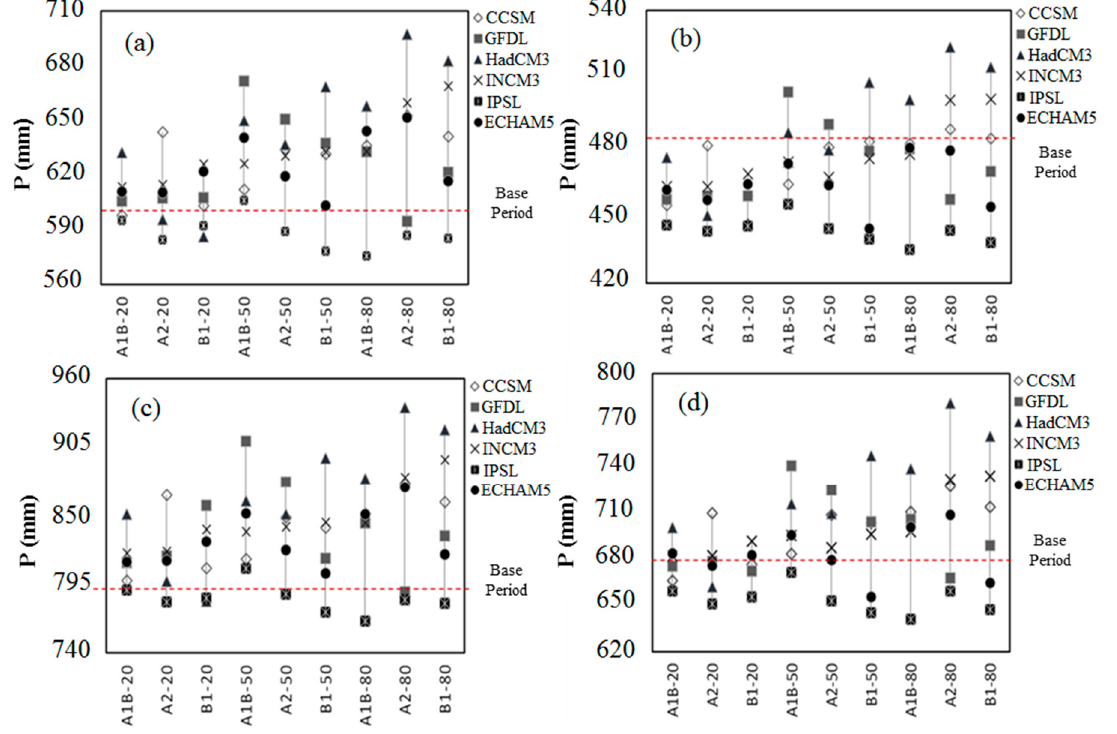
Figure 3. The annual downscaled precipitation based on the A1B, A2, and B1 scenarios for the three time horizons (the 2020s, 2050s, and 2080s) using different GCMs in the sub-basins: SUB-1 ( a ); SUB-2 ( b ); SUB-3 ( c ); and SUB-4 ( d ).